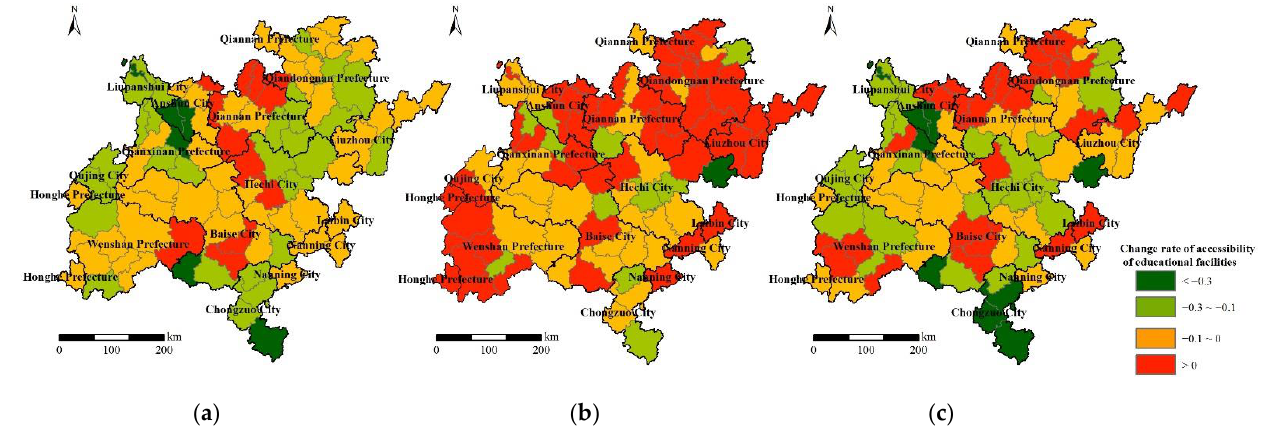
Figure 4. Rate of change in accessibility of educational facilities in the YGGRD: ( a ) 2000 – 2010; ( b )